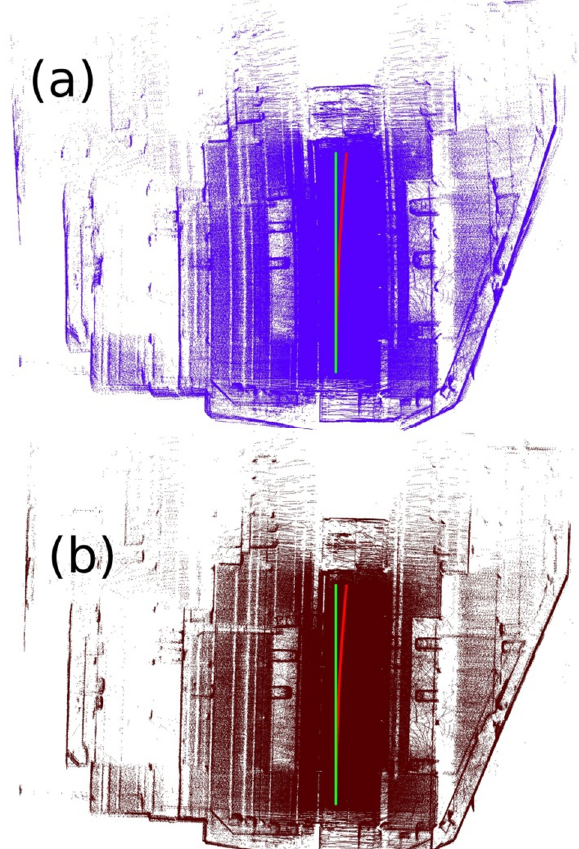
Figure 5. Top views of the point cloud. The point cloud is calculated based on (a) a straight trajectory (shown in green) leading into oblique shapes of straight features, e.g. vertical lines bending left, and (b) the corrected trajectory (shown in red), which has recovered the physical path of VILMA, leading to a point cloud that better corresponds to the physical environment. Both trajectories are visible in both images for visualization